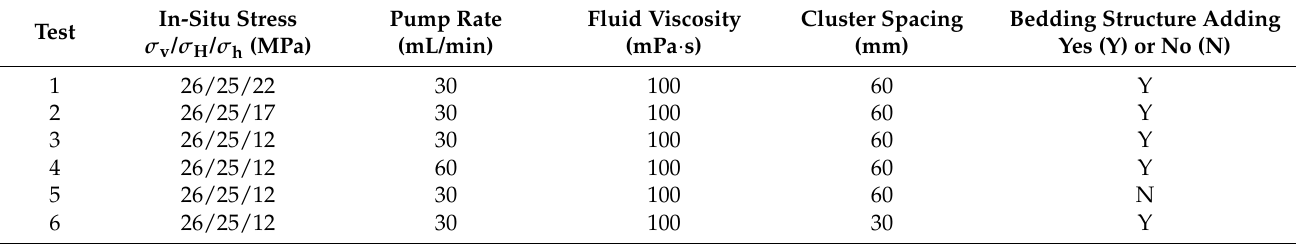
Table 2. Summary of experimental parameters.